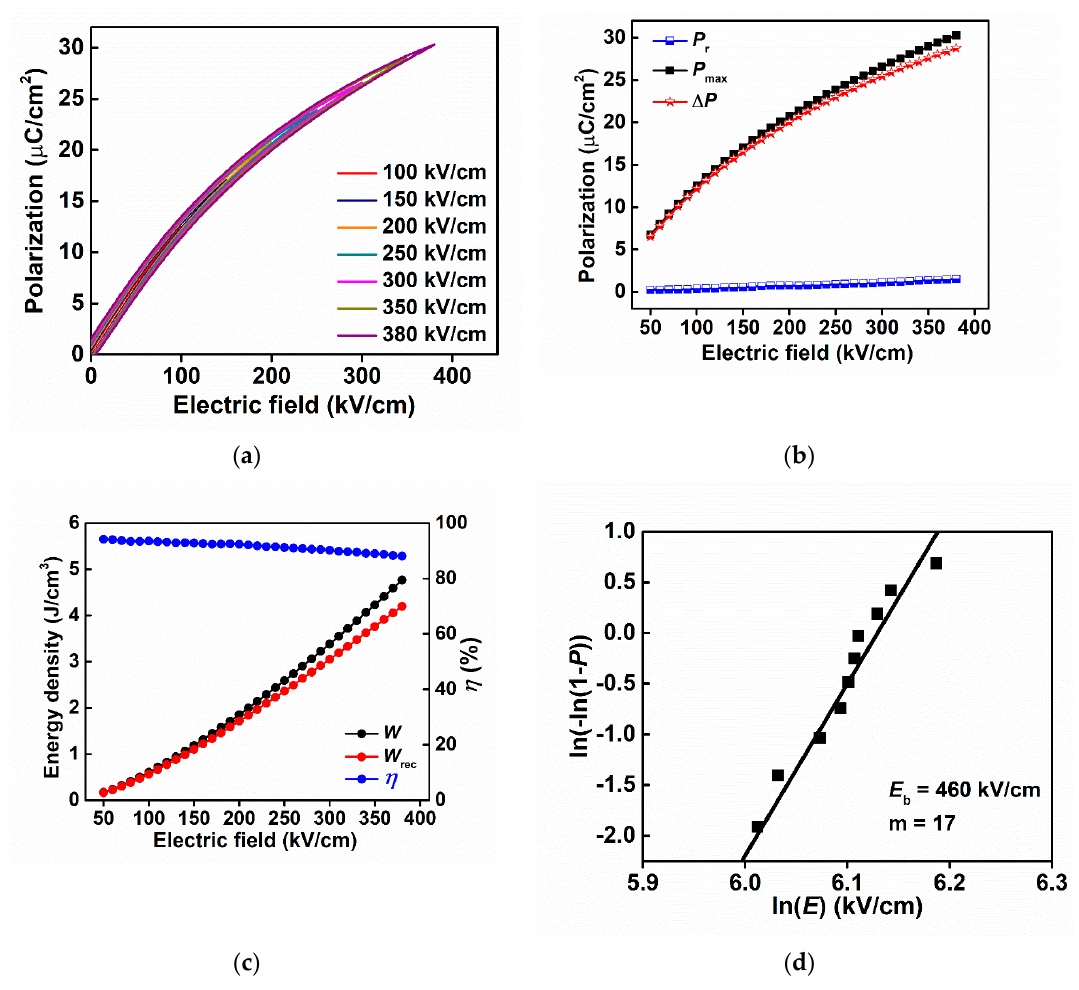
Figure 5. ( a ) The unipolar P – E loops for 6BMZ ceramic; ( b ) the electric filed dependent P max , P r , and Δ P for 6BMZ ceramic; ( c ) the calculated W , W rec , and η versus applied electric field of 6BMZ ceramic; ( d ) Weibull distribution of the breakdown strength data.